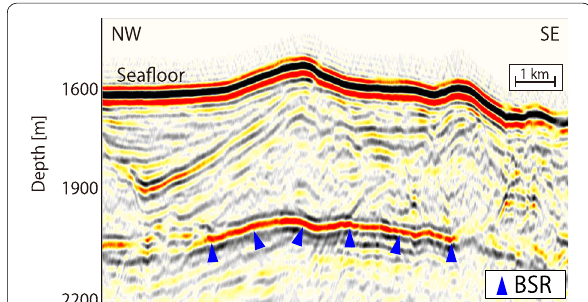
Fig. 2 Example of BSR picking from the seismic profile generated by the KR0211 cruise. The picked BSRs are marked with blue triangles; at these points, the seismic profiles exhibited the characteristic of high-amplitude reverse-polarity waveforms paralleling the seafloor compared with the seafloor reflector waveforms. The two-way